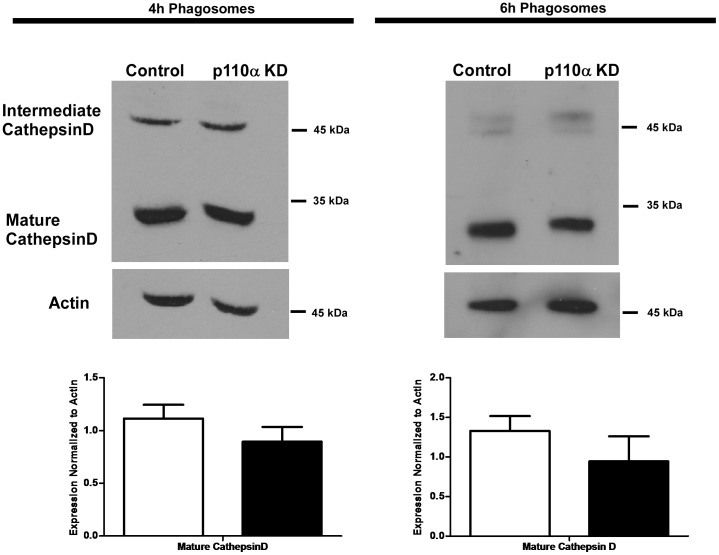
Phagosomes isolated from p110α knockdown cells show normal recruitment and processing of the protease cathepsin D.Lysates from 4 and 6 hour phagosomes were prepared, separated by SDS-PAGE and transferred to nitrocellulose membrane. Blots were probed with an antibody for cathepsin D. Actin is shown as a loading control. Although a trend towards less cathepsin D in the phagosome lysates from p110α knockdown cells was observed, it was not found to be statistically significant. Empty bars  =  control cells, solid bars  =  p110α knockdown cells. Data are means +/− s.e.m., from four independent experiments.